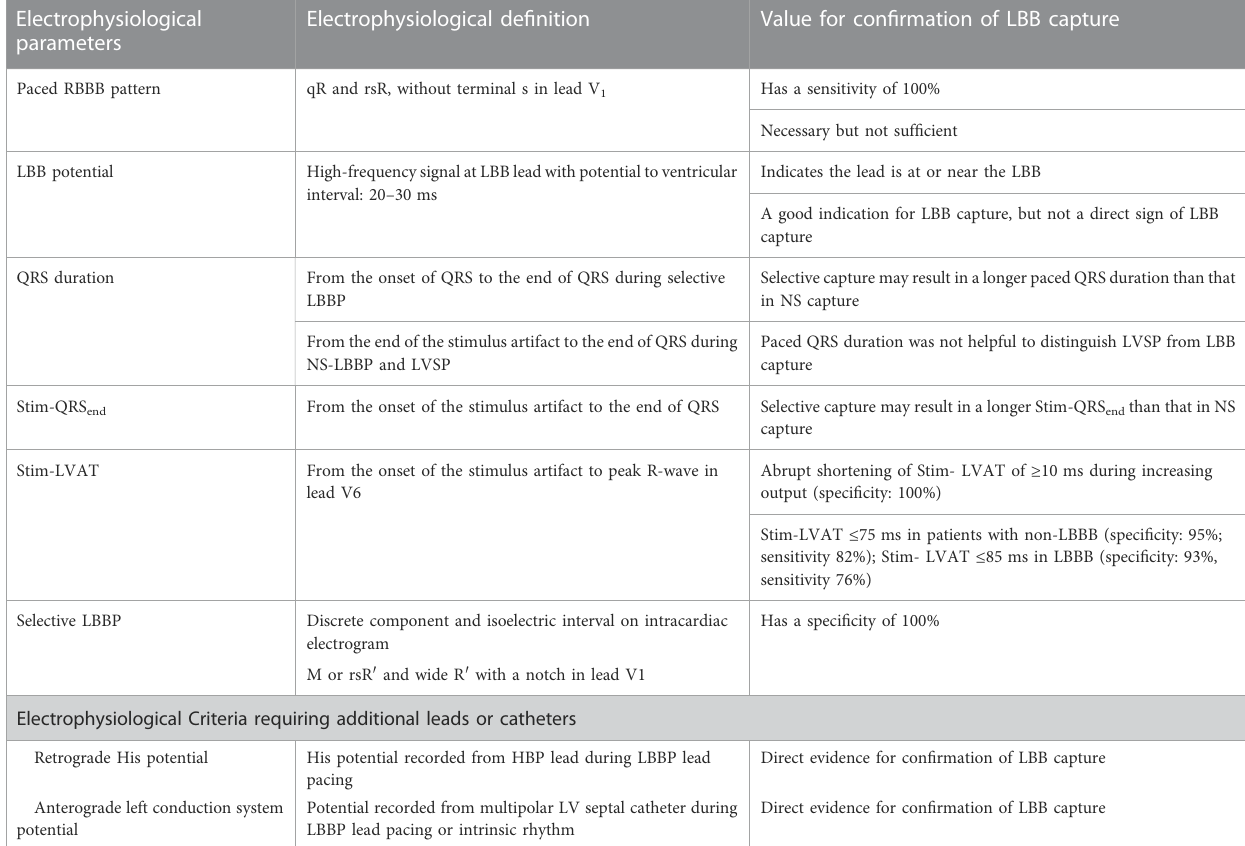
TABLE 2 Electrophysiological Parameters and Values for con fi rming LBB capture. LBB: left bundle branch; LBBP: left bundle branch pacing; NS: non-selective; RBBB: right bundle branch block; Stim-LVAT: stimulus to left ventricular activation time; Stim-QRSend: time from stimulus to the end of QRS. Adapted from Wu et al.